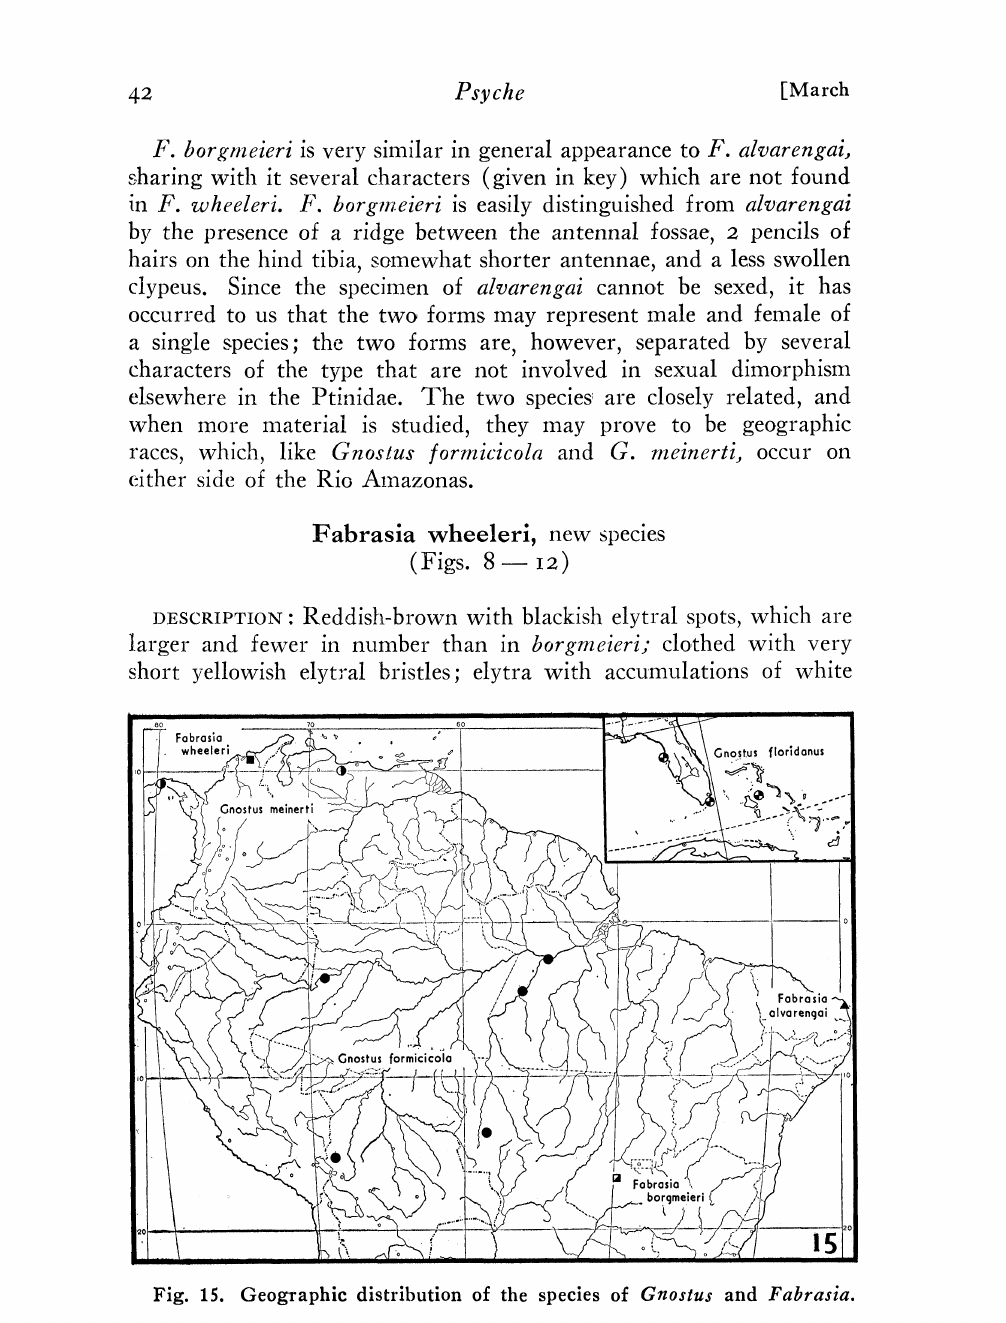
Fig. 15. Geographic distribution of the species of Gnostus and